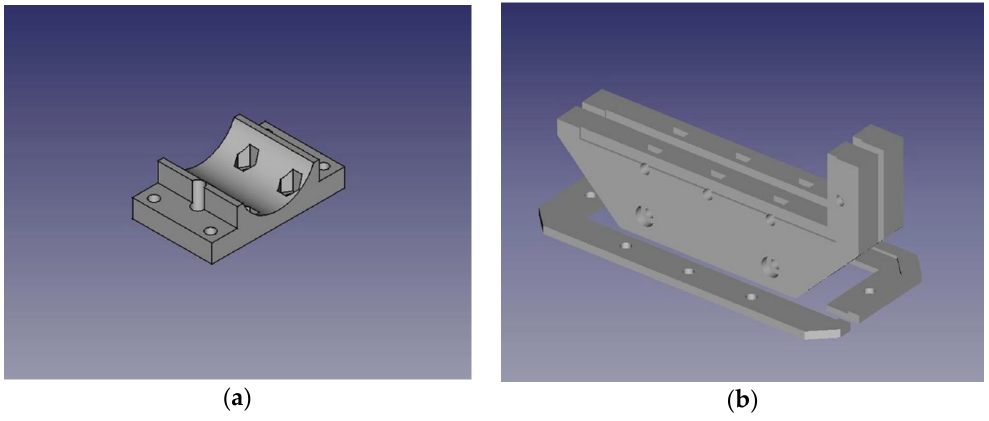
Figure 3. ( a ) The spindle mount model. ( b ) The board holder model.